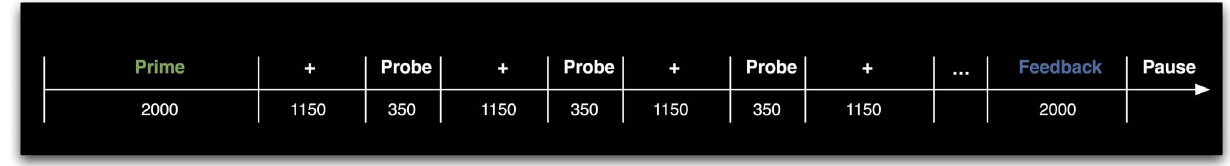
Figure 1. Design. Basic design of the experiment.